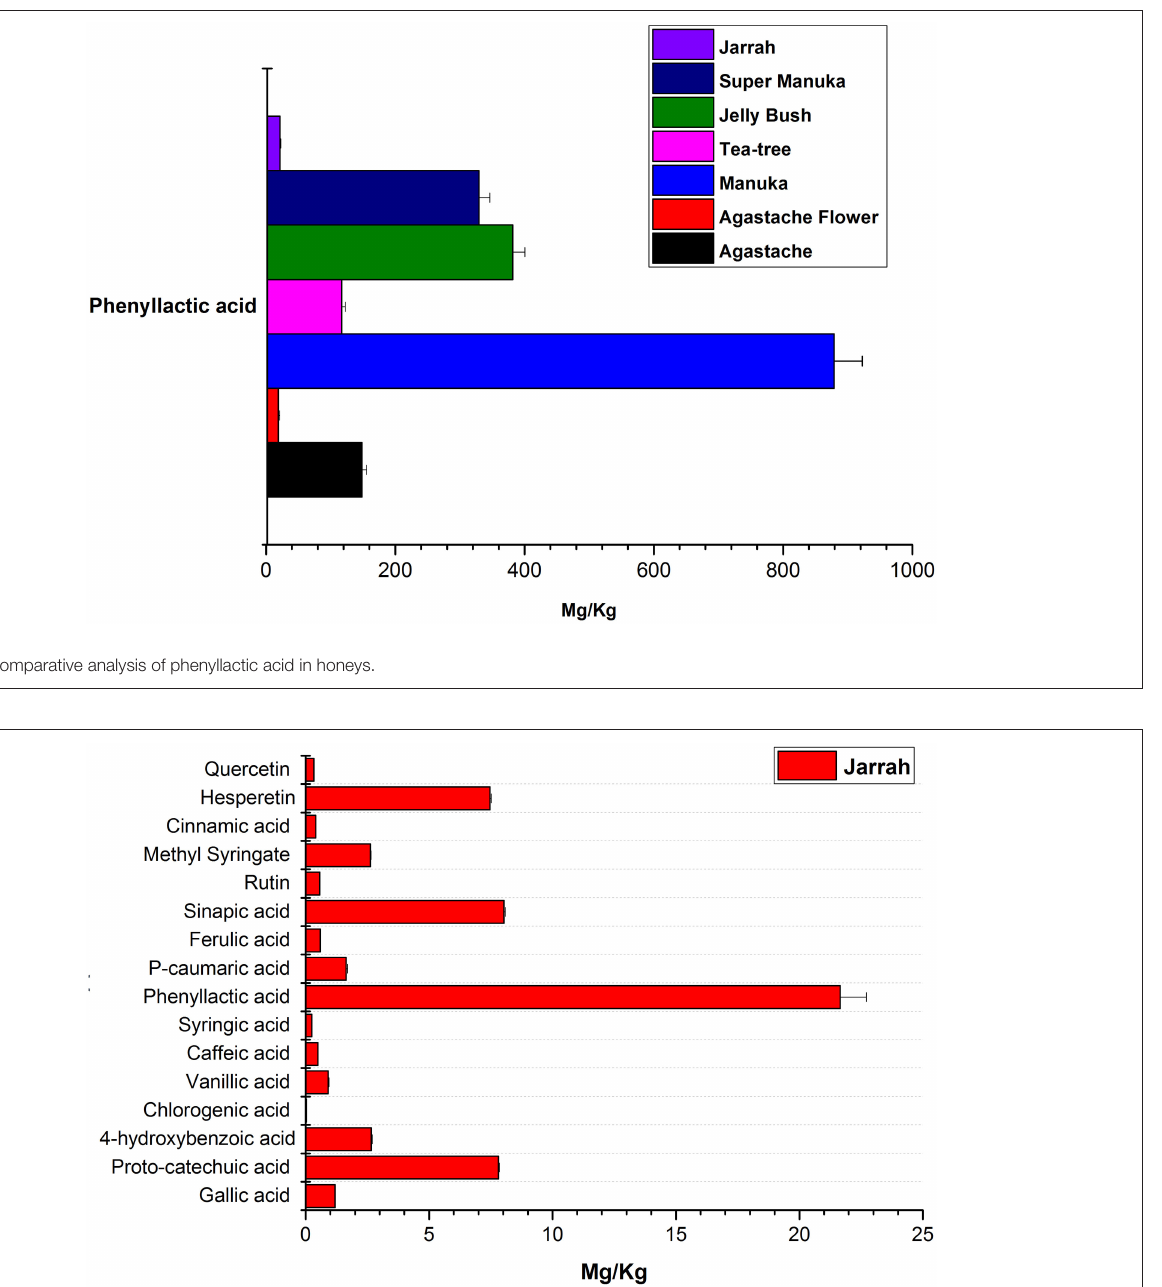
FIGURE 9 | Phenolic profile of Jarrah